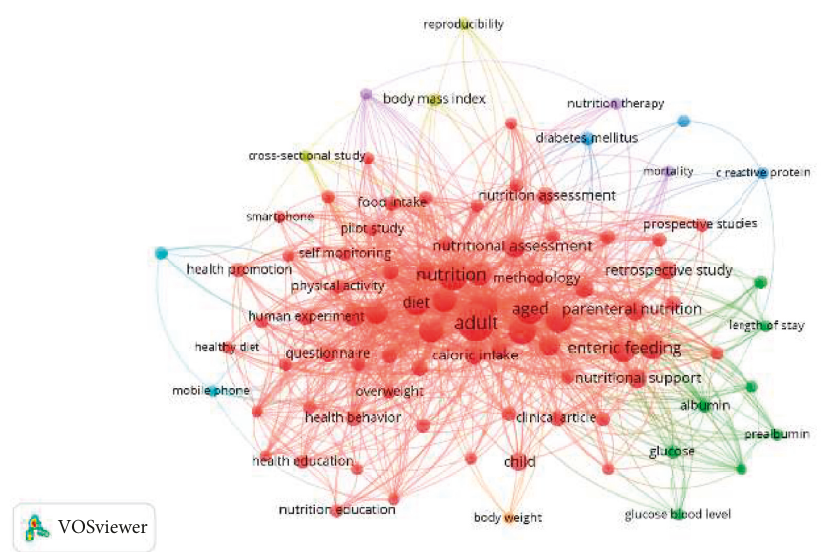
Figure 7: Network visualization of each cluster.